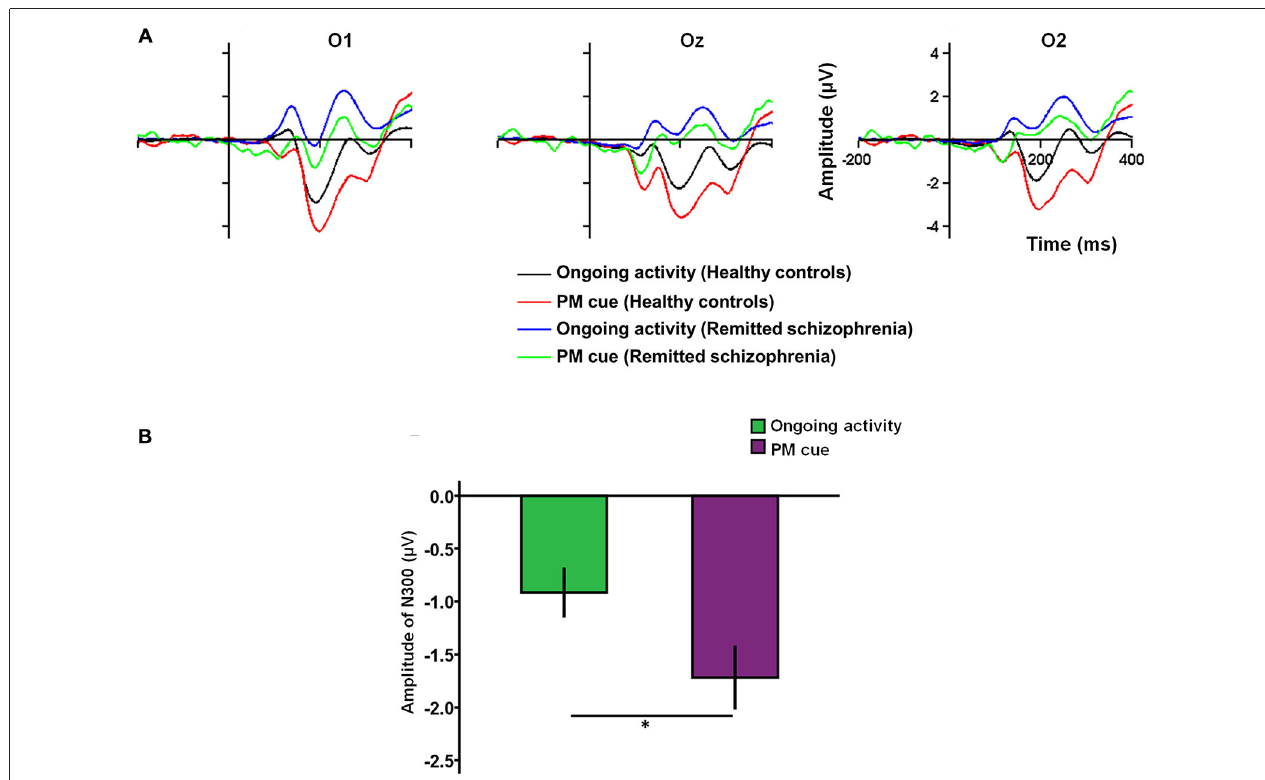
FIGURE 2 | The N300 related to prospective memory (PM) cue detection. (A) The N300 over the occipital region (O1/Oz/O2) for PM cue trials and ongoing activity trials in symptomatically remitted patients with schizophrenia and healthy controls. (B) Bar plots illustrating the amplitudes of the N300 according to task type (PM vs. ongoing task). Error bars indicate SEM, ( ∗ p <